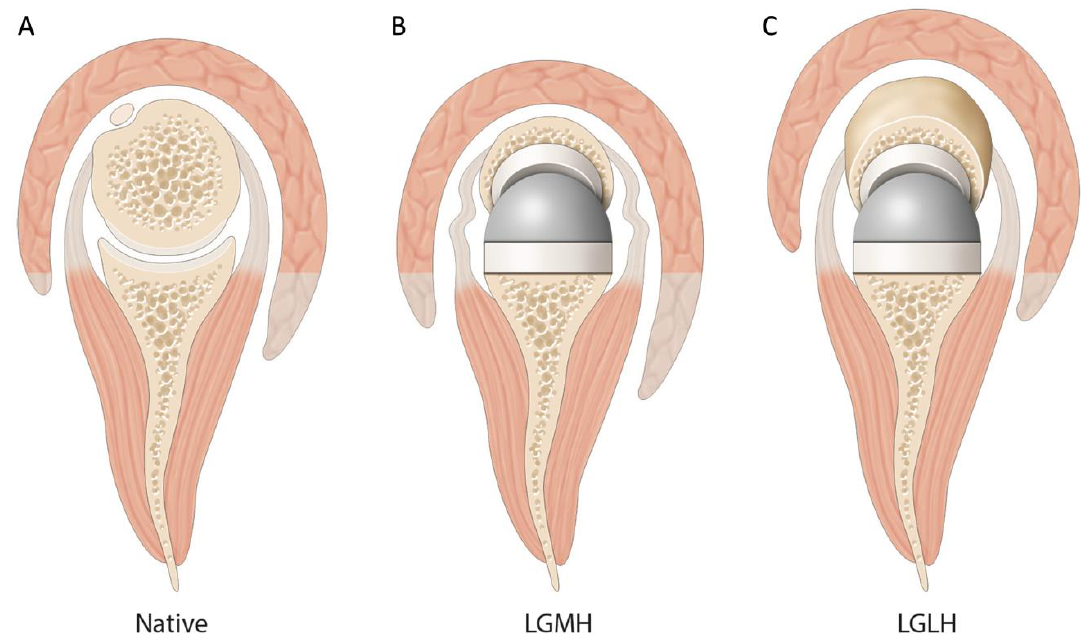
Figure 1. Factors influencing postoperative external rotation. ( A ) Native shoulder. The center of rotation is in the humeral head, and the level of deltoid arm does not allow deltoid recruitment. ( B ) A combination of lateral glenoid/medial humerus RSA. As in native shoulders, the bony lateralization of the center of rotation decreases recruitment of the deltoid for rotation. Additionally, due to the medialized center of rotation compared to the native shoulder, the rotator cuff is slackened and thus less efficient in rotatory motion. ( C ) A combination of lateral glenoid/lateral humerus RSA. Additional lateralization on the humeral side allows important deltoid recruitment and a tenodesis effect and a retensioning of the remnant posterior cuff.